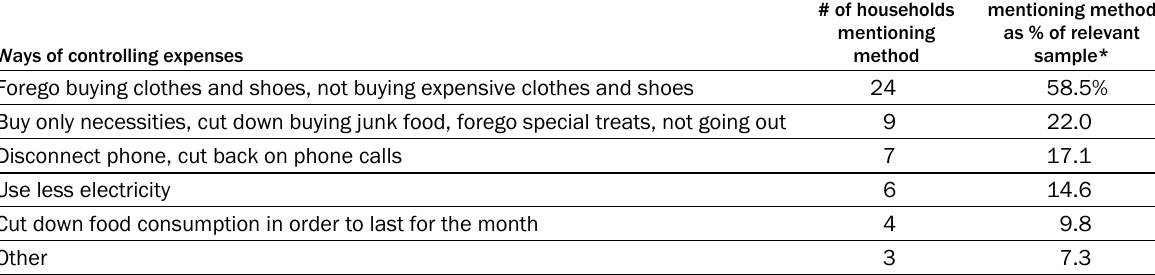
Table 4. Coping Strategies: Control Household Expenses